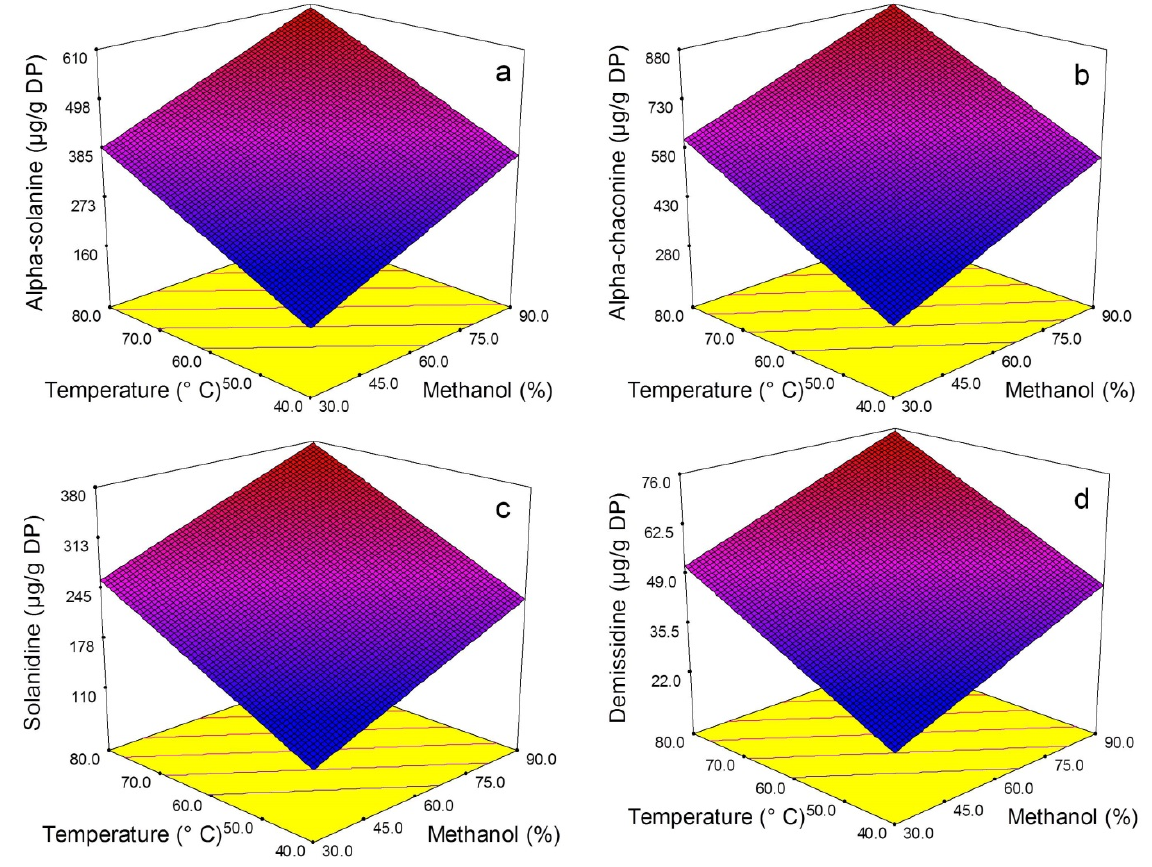
Figure 2. Response surface plots of potato peel pressurized liquid extracts showing the effect of temperature and methanol concentration on α -solanine ( a ), α -chaconine ( b ), solanidine ( c ), and demissidine ( d )